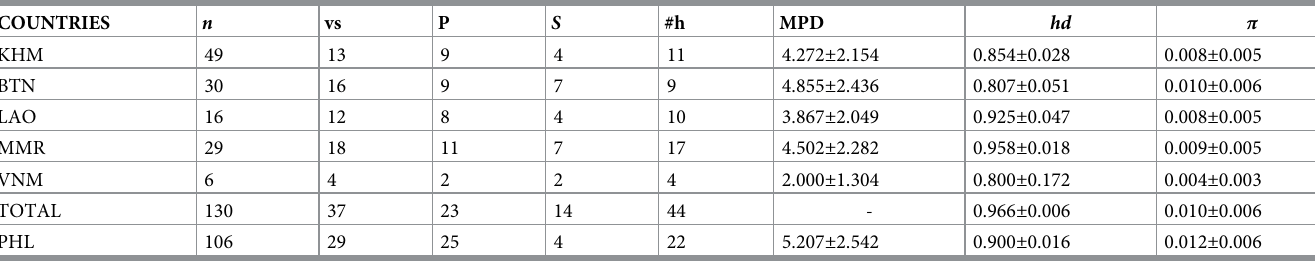
PHL = Philippines; KHM = Cambodia; BTN = Bhutan; MMR = Myanmar; VNM = Vietnam; n = number of samples; vs = variable sites; P = parsimony informative sites; S = singleton variable sites; #h = number of haplotypes; MPD = mean pairwise differences (SD); hd = gene diversity: haplotype level (SD); π = nucleotide diversity